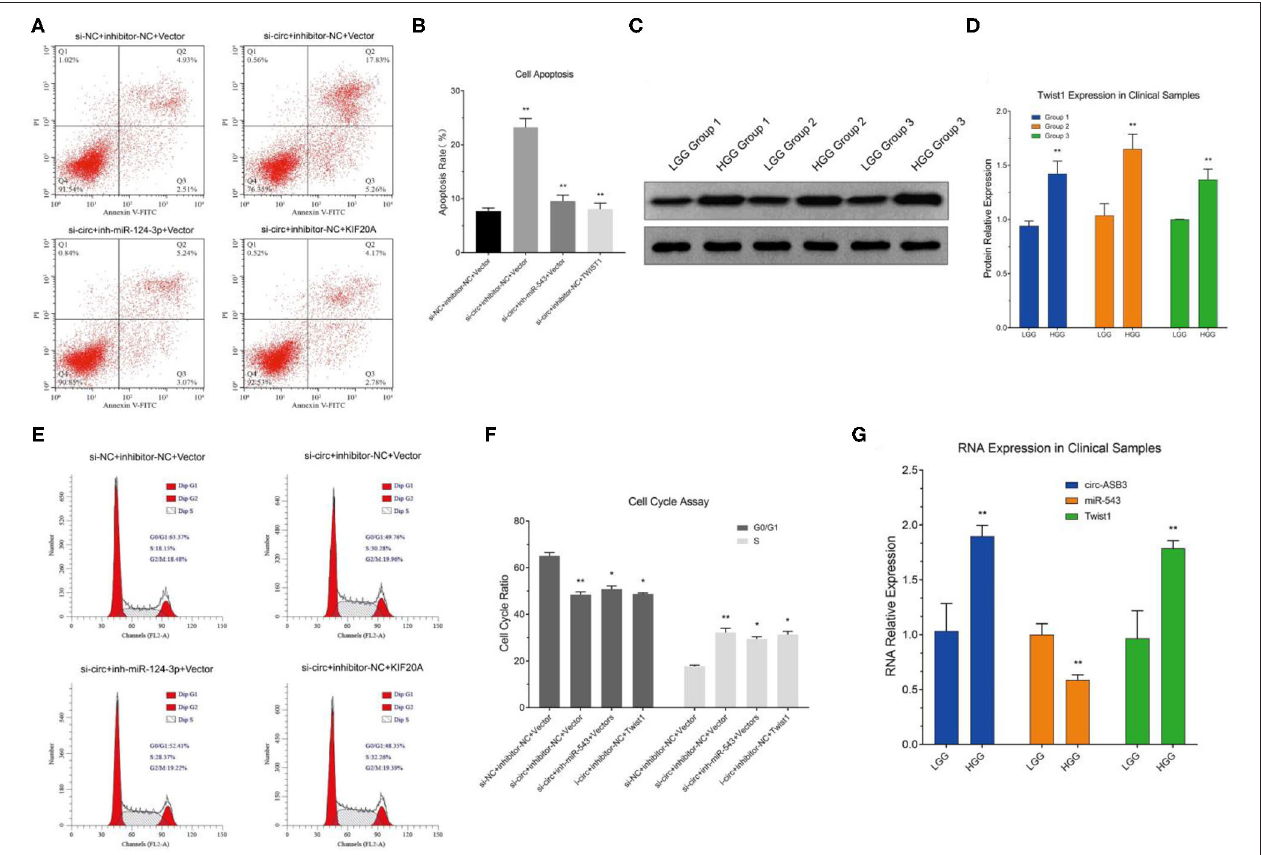
FIGURE 5 | Circ-ASB3 inhibited glioma apoptosis and induced cell cycle arrest through miR-543/Twist1 axis, clinical sample validation. (A,B) Apoptosis rate was detected by Annexin V-FITC staining of A172 cells transfected with si-circ-ASB3, miR-543 inhibitor and Twist1 mimics. (E,F) The cell cycle of A172 cells transfected with si-circ-ASB3, miR-543 inhibitor and Twist1 mimics was examined by Flow cytometry. (G) PCR detection of target signal pathway RNA in clinical samples. (C,D) Western Blot analysis of Twist1 protein content in clinical samples, * P < 0.05, ** P < 0.01; representative images are